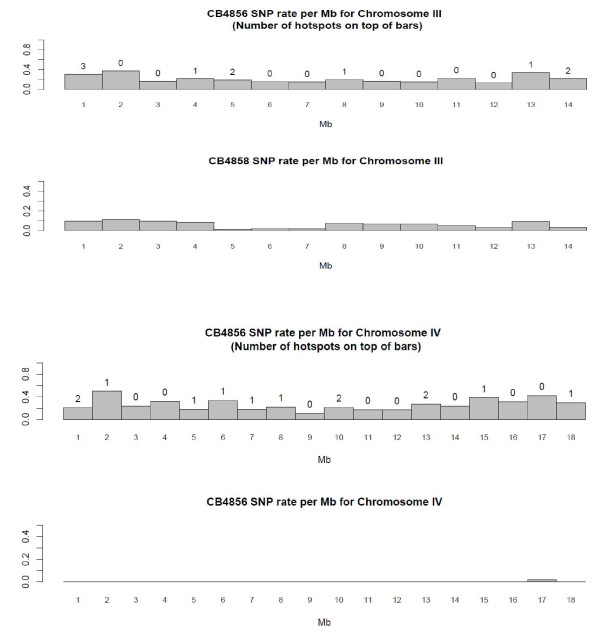
SNP rate per Mb for Chromosomes III and IV in CB4856 and CB4858.